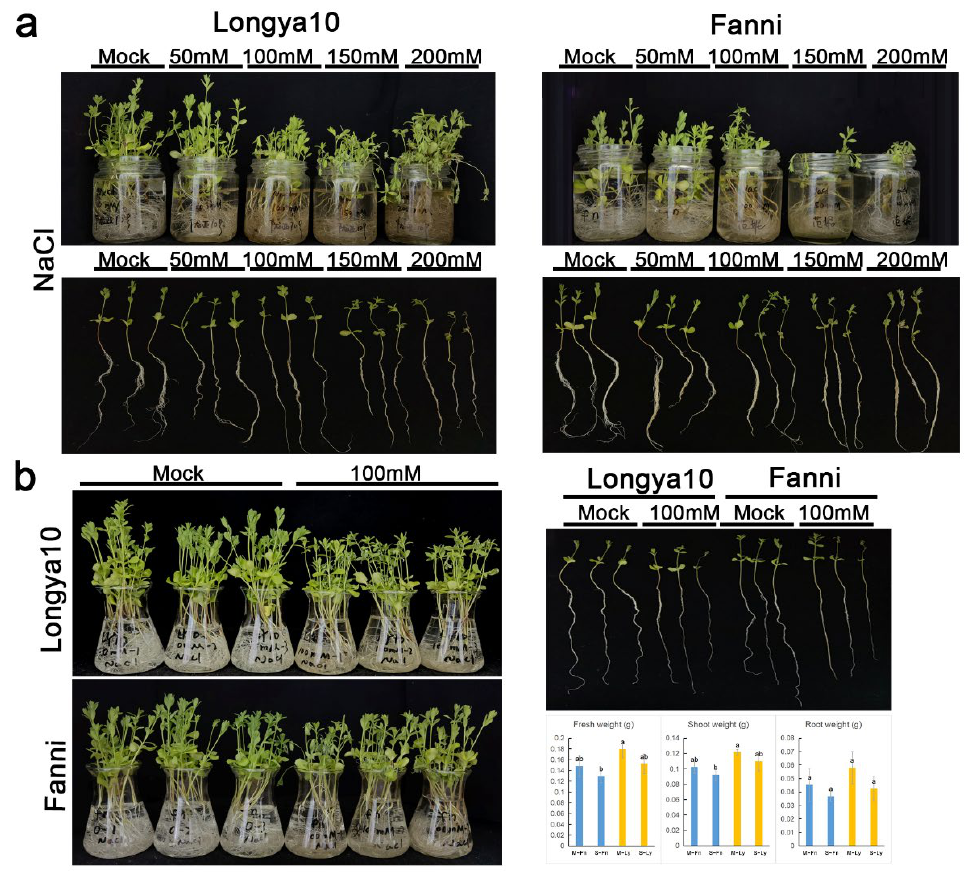
Figure 1. ( a ) Saline stress treatment with 0, 50, 100, 150, and 200 mM NaCl solution for 48 h in Fanni and Longya10. ( b ) Morphological changes in Fanni and Longya10 under 100 mM NaCl solution for 48 h. The mock condition was compared with stress condition as control. M−Fn and M−Ly represent flax growth in the mock condition derived from Fanni and Longya10 plants, respectively. S−Fn and S−Ly represent flax growth in the stress condition derived from Fanni and Longya10 plants, respectively. The values marked a or b between two columns are significantly different at p < 0.05.